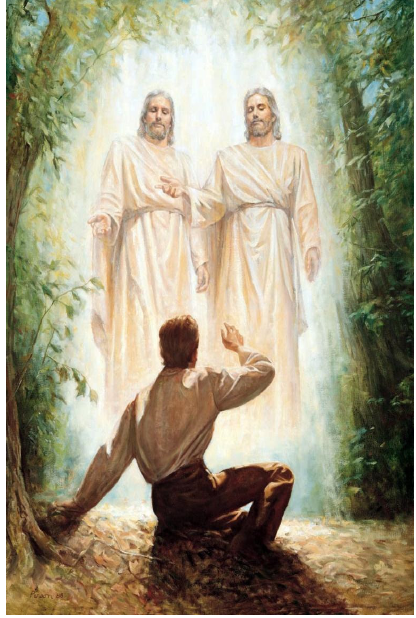
Figure 9. The First Vision by Delwin Oliver Parson 1988. Courtesy of The Church of Jesus Christ of Latter-day Saints (© By Intellectual Reserve,